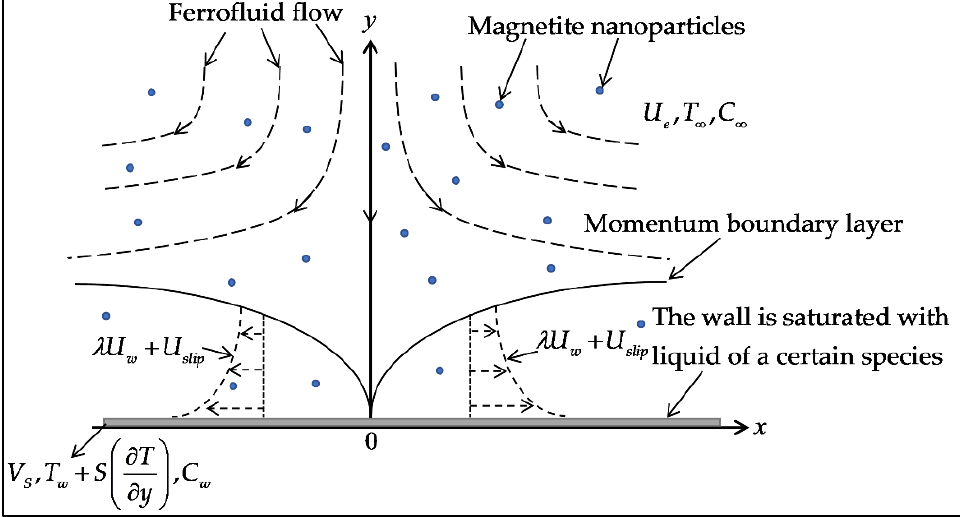
Figure 1. Present flow problem’s physical model.